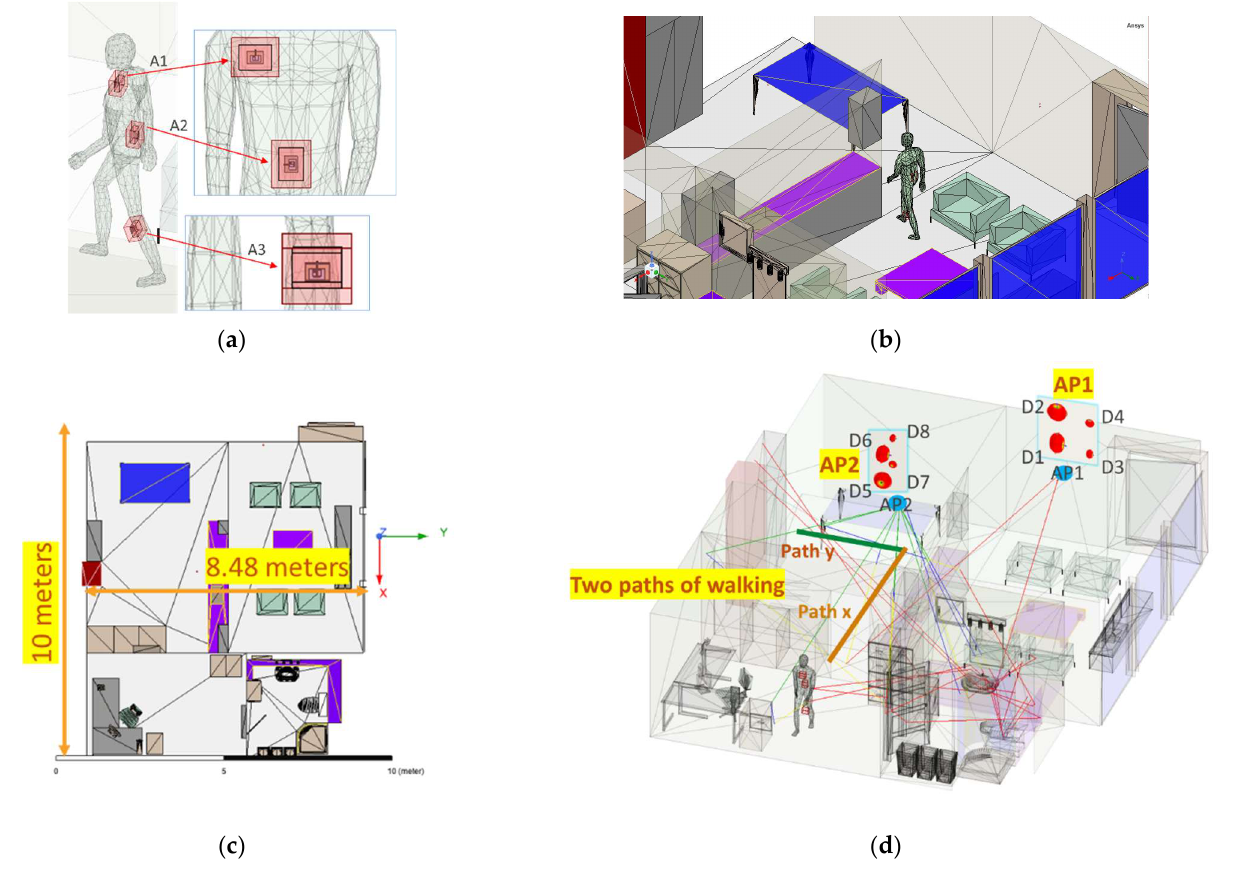
Figure 14. Shooting-bouncing ray (SBR+) simulation set up: ( a ) three textile antennas were placed on a human body of average tissue material; ( b ) a human model was placed inside the indoor office area and moved around; ( c ) office area dimensions; ( d ) location of the access points (AP) and the paths of moving the body.